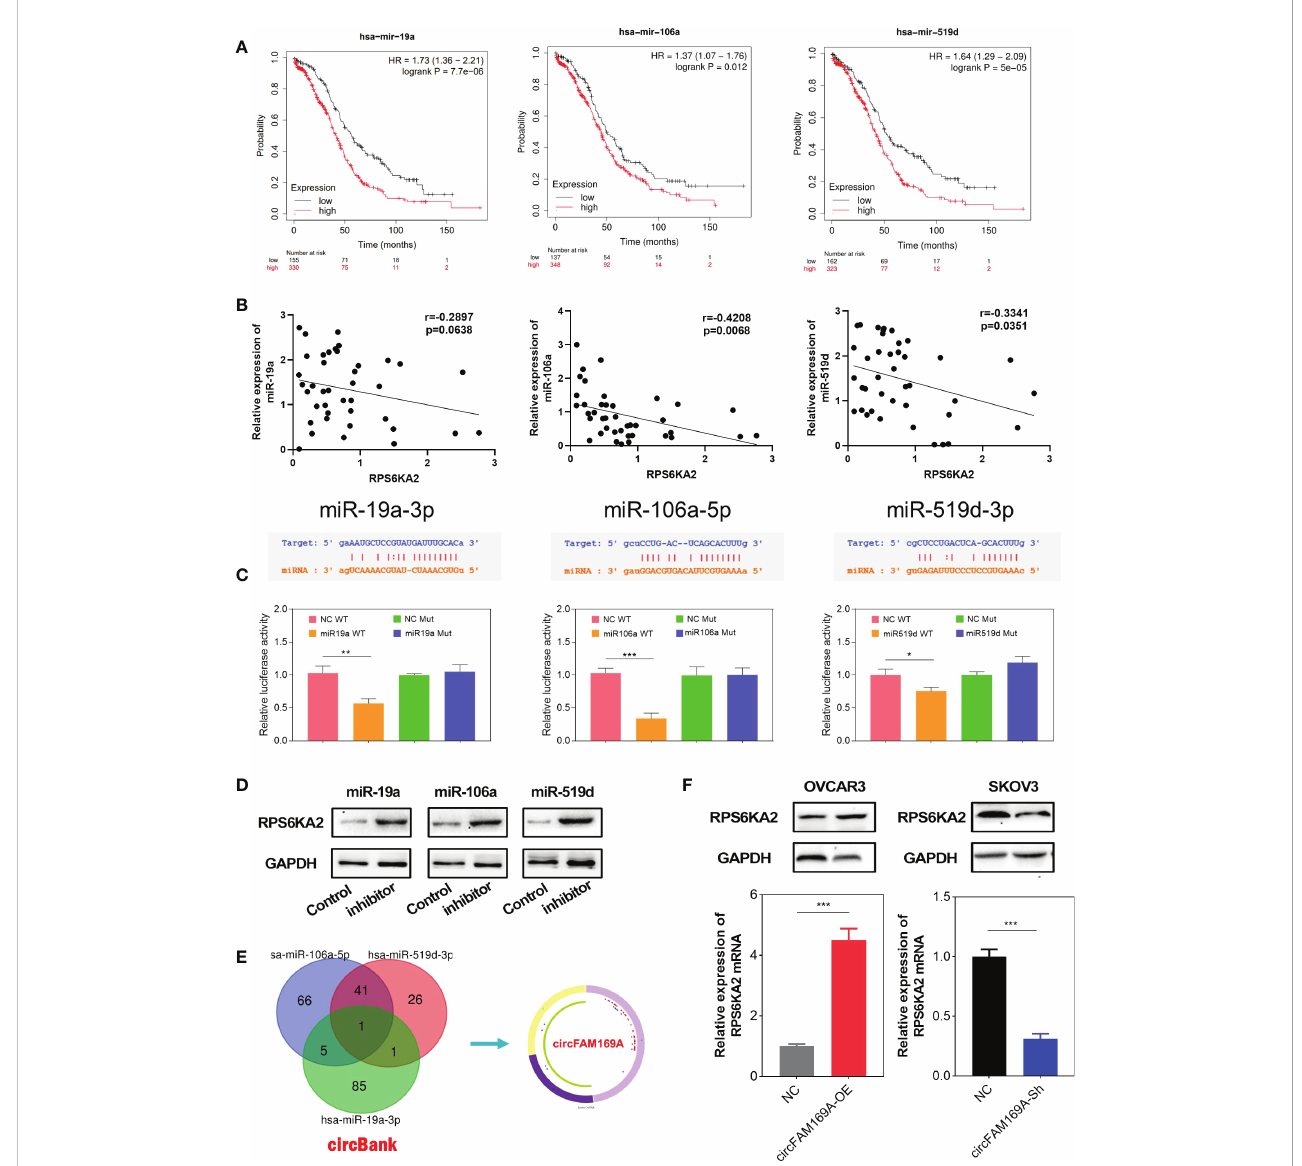
FIGURE 5 miR-19a-3p, miR-106a-5p and miR-519d-3p targeted RPS6KA2. (A) Prognostic estimation of miR-19a-3p, miR-106a-5p and miR-519d-3p in ovarian cancer. (B) The correlation between miRNAs and RPS6KA2 expression. (C) Dual-Luciferase reporter assay was performed to verify the location between RPS6KA2 and miR-19a-3p, miR-106a-5p and miR-519d-3p. (D) The expression of RPS6KA2 after inhibiting upstream miRNAs. (E) circFAM169A was screened through overlapping websites of circBank. (F) The mRNA and protein level of RPS6KA2 after transfection with circFAM169A mimics and circFAM169A inhibitor. (* indicates p<0.05, ** indicates p<0.01, *** indicates